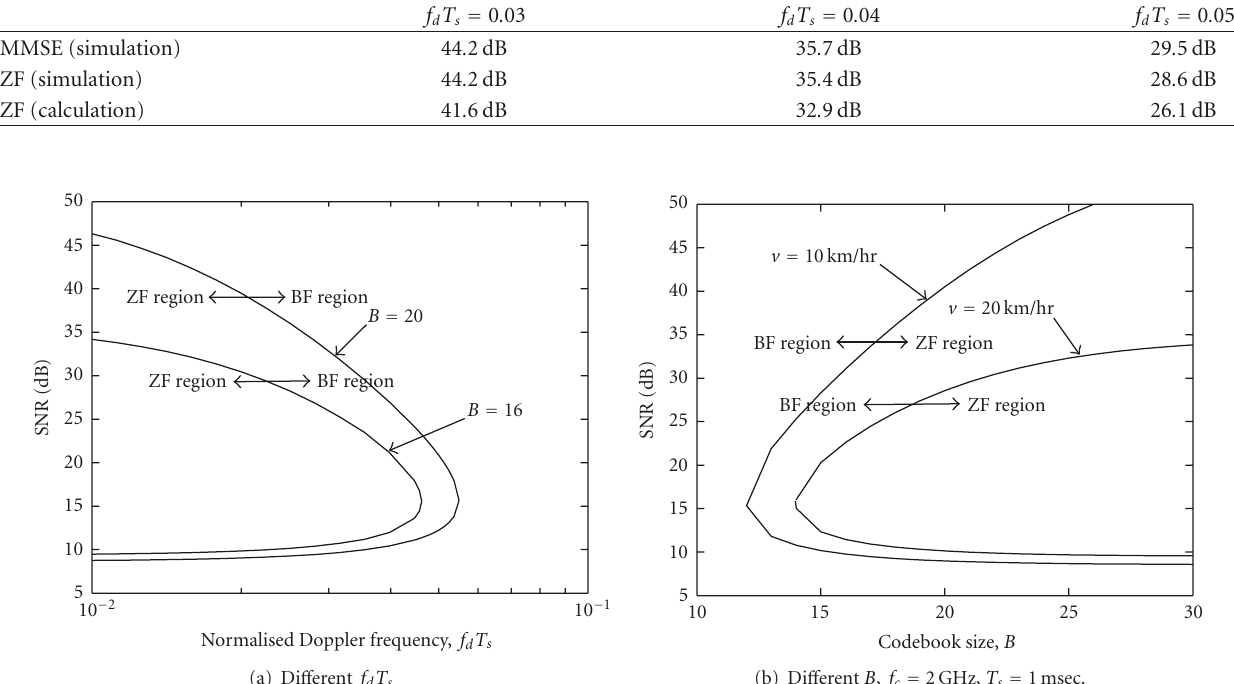
Figure 4: Operating regions for BF and ZF with both CSI delay and quantization, N t = 4.